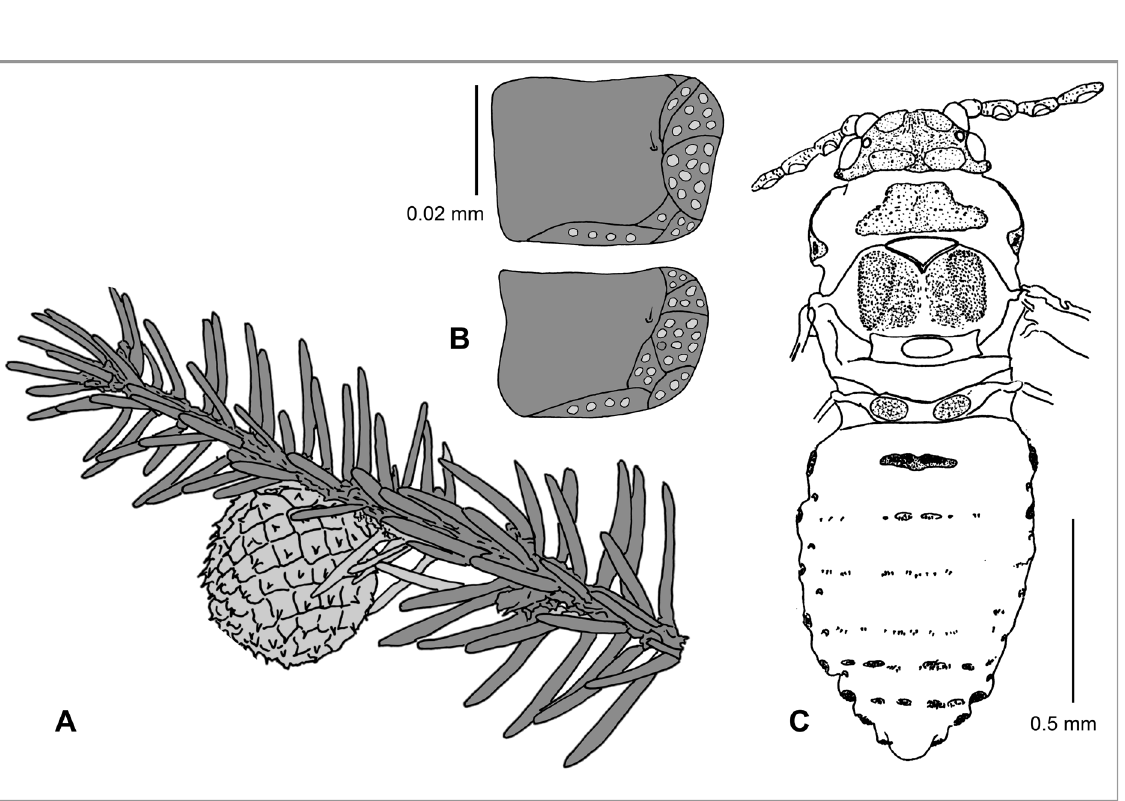
Fig. 6. Adelges (Dreyfusia) nordmannianae (Eckstein, 1890). A . Gall on Picea orientalis (orig.). B . First instar hibernating fundatrix, spinal plates on meso- and metathorax (left side), showing arangement of wax gland pits (after Eichhorn 1956). C . Gallicola (after Carter 1971, redrawn and slightly modified from Heie 2004).